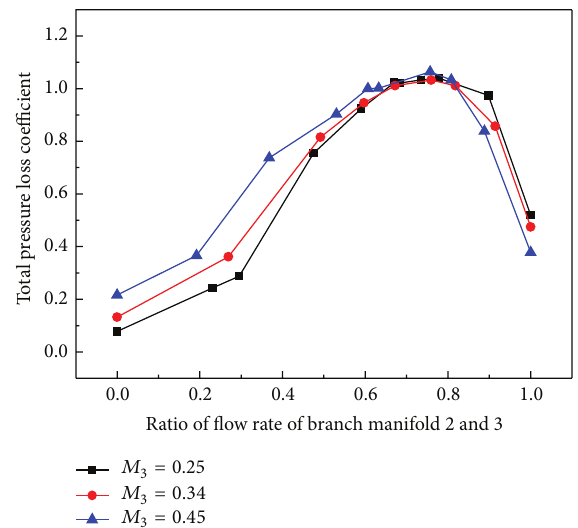
Figure 11: Total pressure loss coefficient from branch manifold 2 to branch manifold